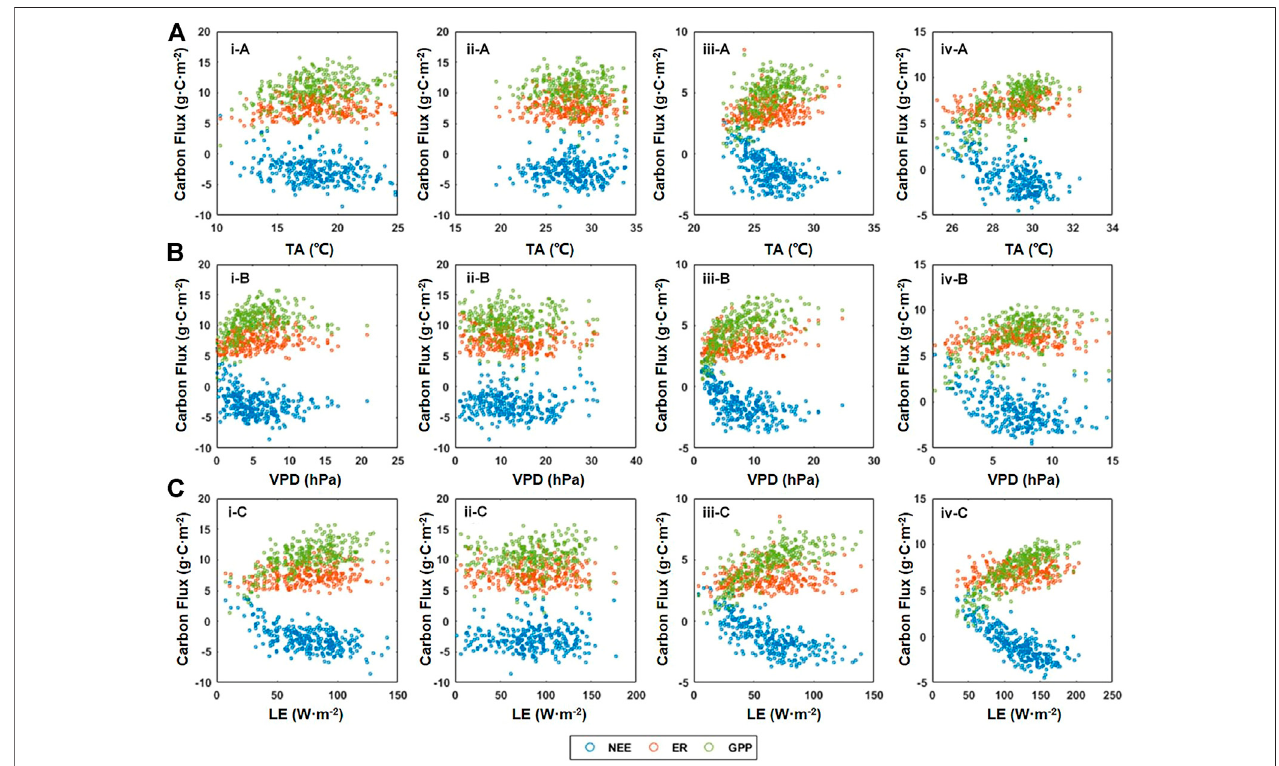
FIGURE 10 | The relationship among environmental factors and ecosystem carbon fl uxes. (i – iv) for Cha, Qia, Din and MPM sites; (A – C) for TA, VPD and LE, respectively.